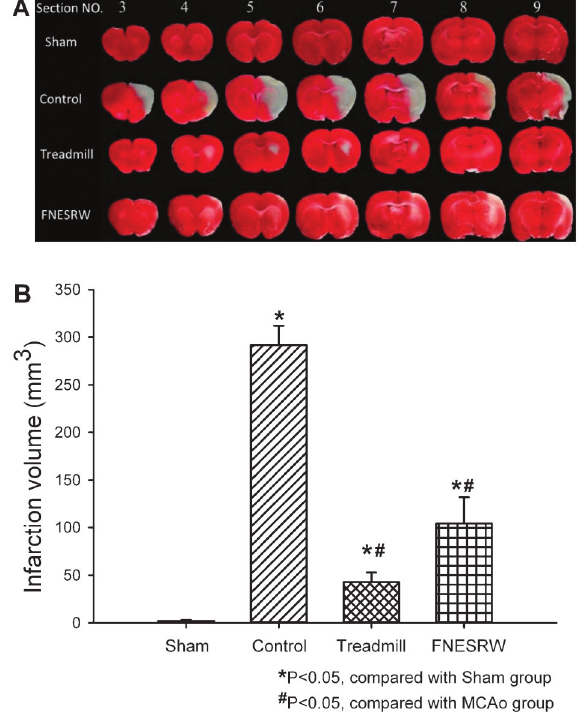
Figure 9. Cerebral infarction volume 7 days after reperfusion. A , Brain slices stained with TTC to visualize damaged lesions. B , Average of the lesion volumes that were assessed using the reduction in TTC staining (means±SD). FNESRW: forced non- electric-shock running wheel; MCAo: middle cerebral artery occlusion. Analysis of variance showed a significant difference (P , 0.05), with an F-value of 107.872 for 3 and 32 degrees of